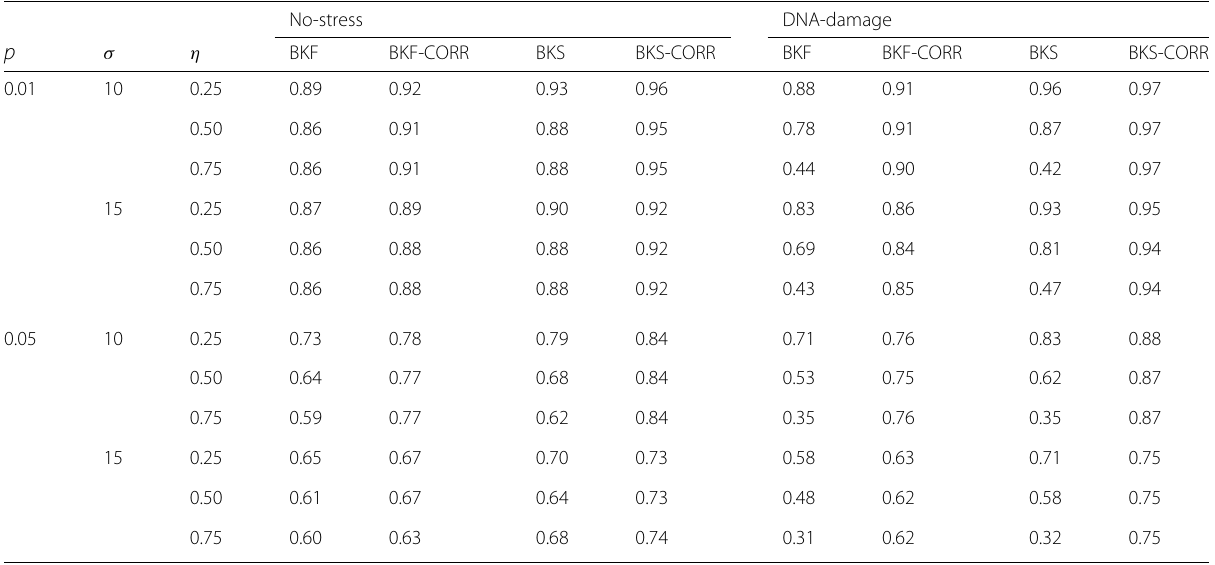
Table 2 Average correct state estimation rates over 1000 independent runs for time series with length T = 40 No-stress